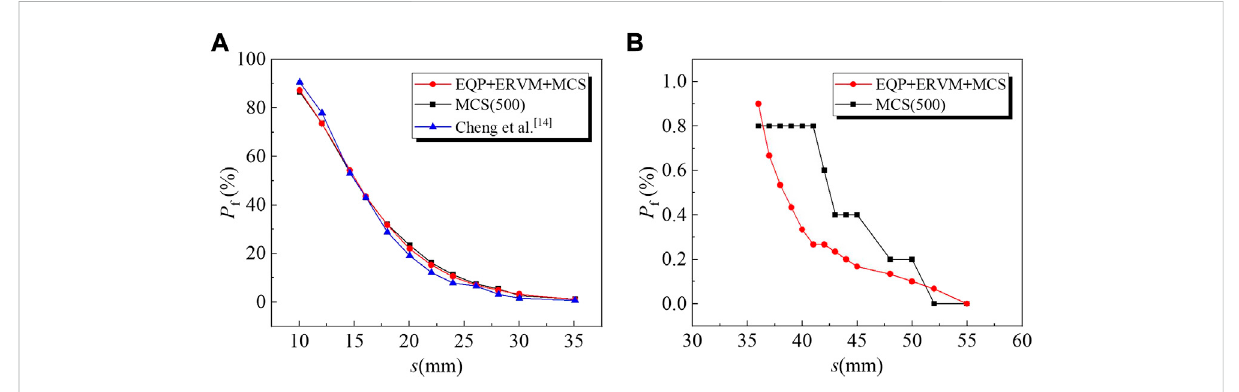
FIGURE 8 Comparison between the simpli fi ed framework, MCS (500) and Cheng et al.